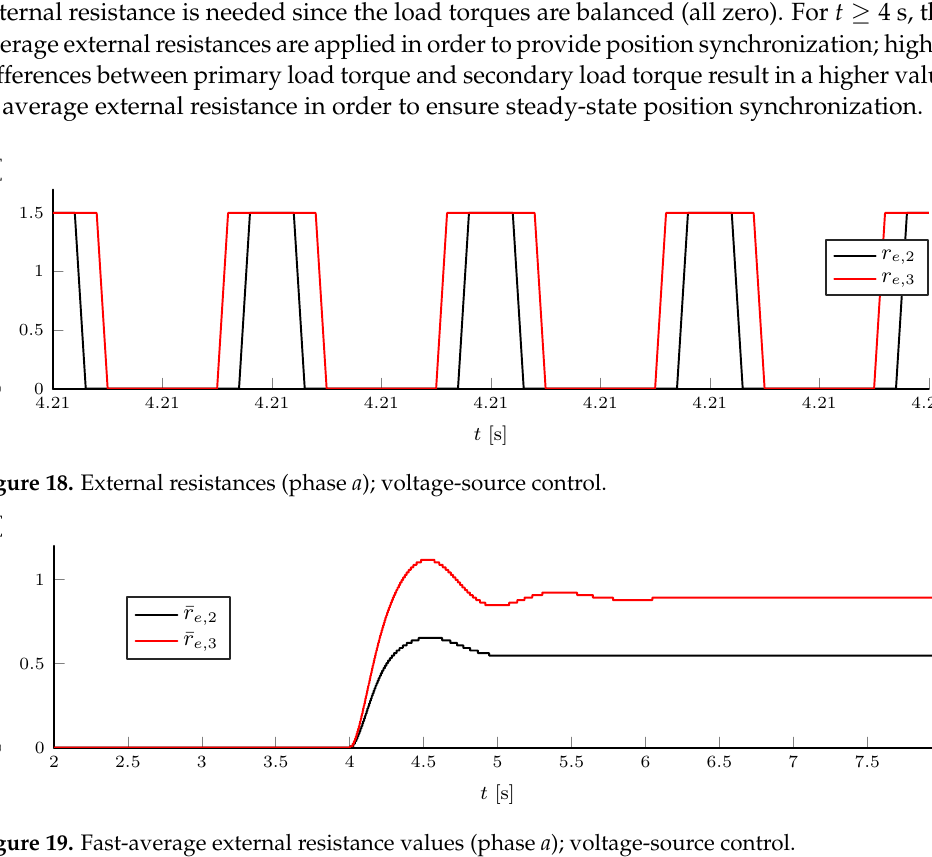
Figure 19. Fast-average external resistance values (phase a ); voltage-source control.